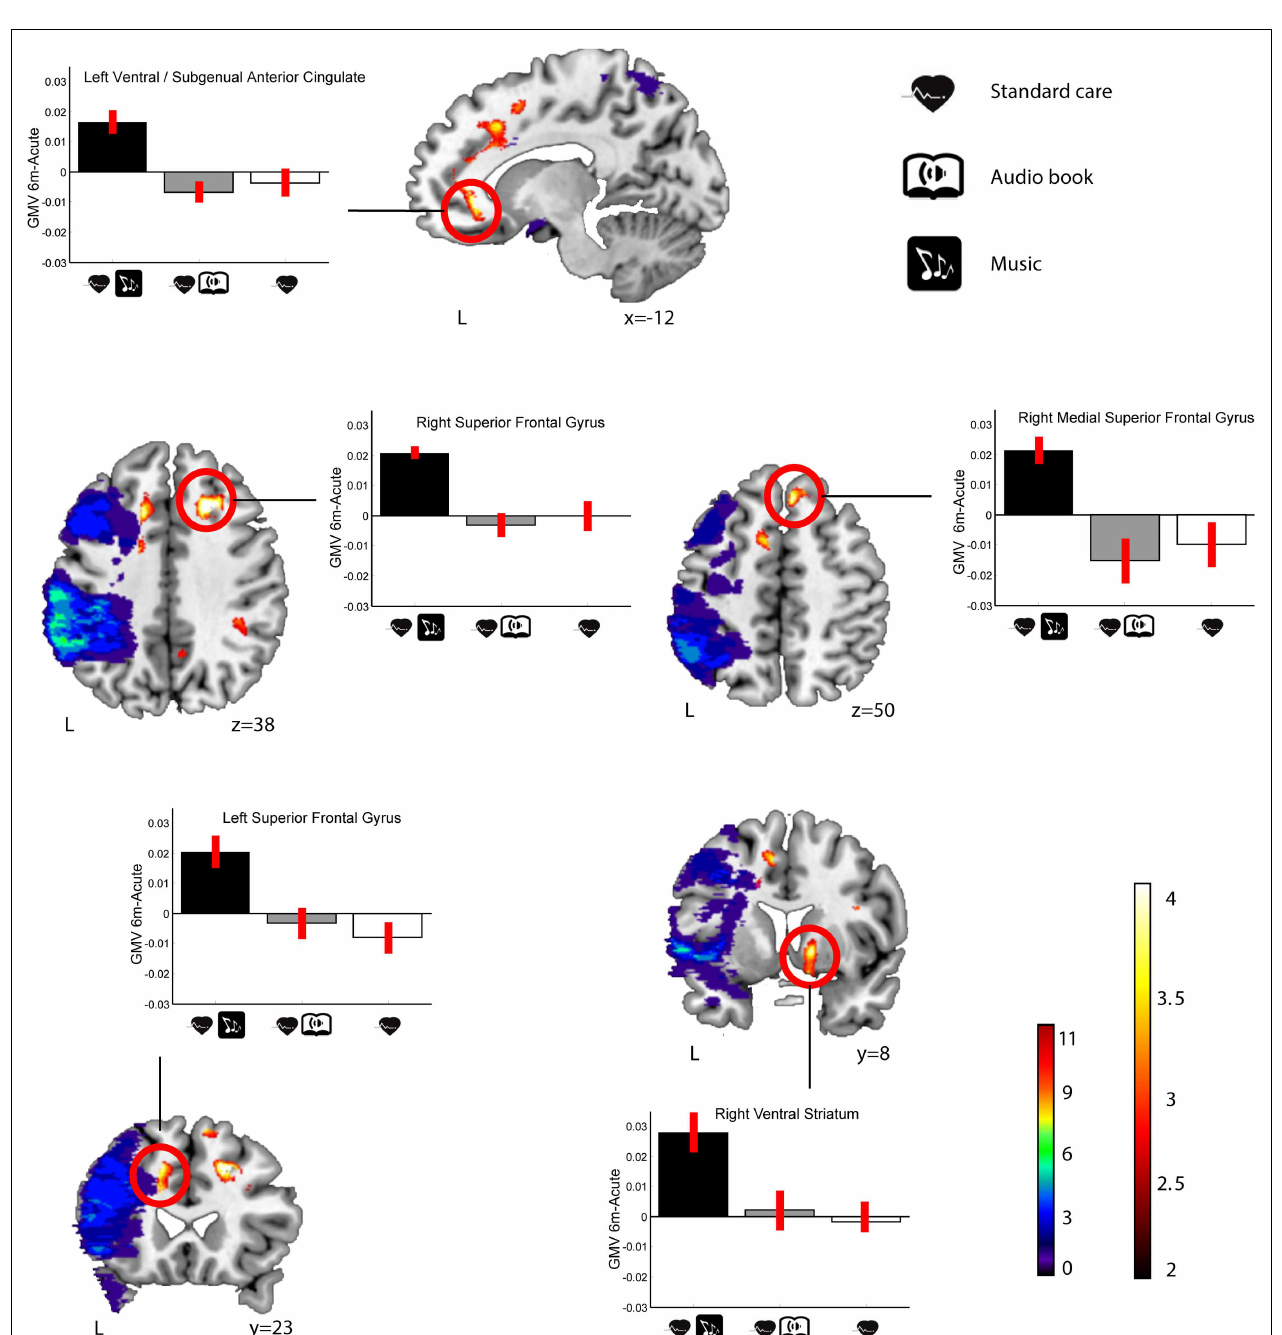
(mean ± SEM) for each of the clusters showing an interaction effect (white: CG, gray: ABG, black: MG). Neurological convention is used. Results are shown at p < 0.01 (uncorrected) with ≥ 50 voxels of spatial extent and overlaid over a canonical template with MNI coordinates at the bottom right of each slice (see also Table 5 ). L, left